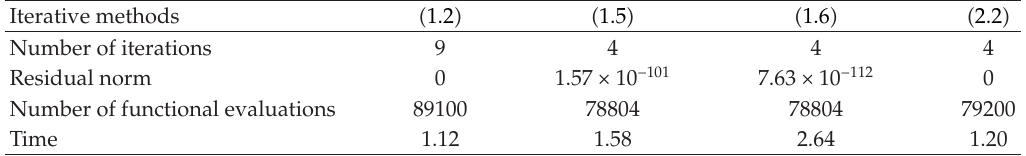
Table 3: Results of comparisons for di ff erent methods in Example 5.2 when n (cid:4) 99. Iterative